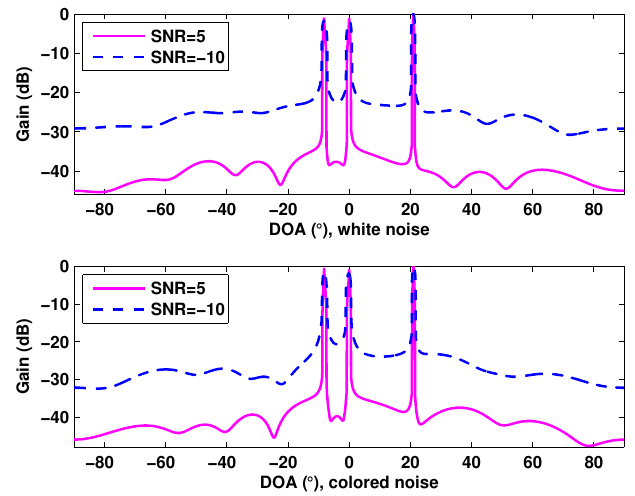
Figure 2. Spatial spectrum of the proposed method for white noise and colored